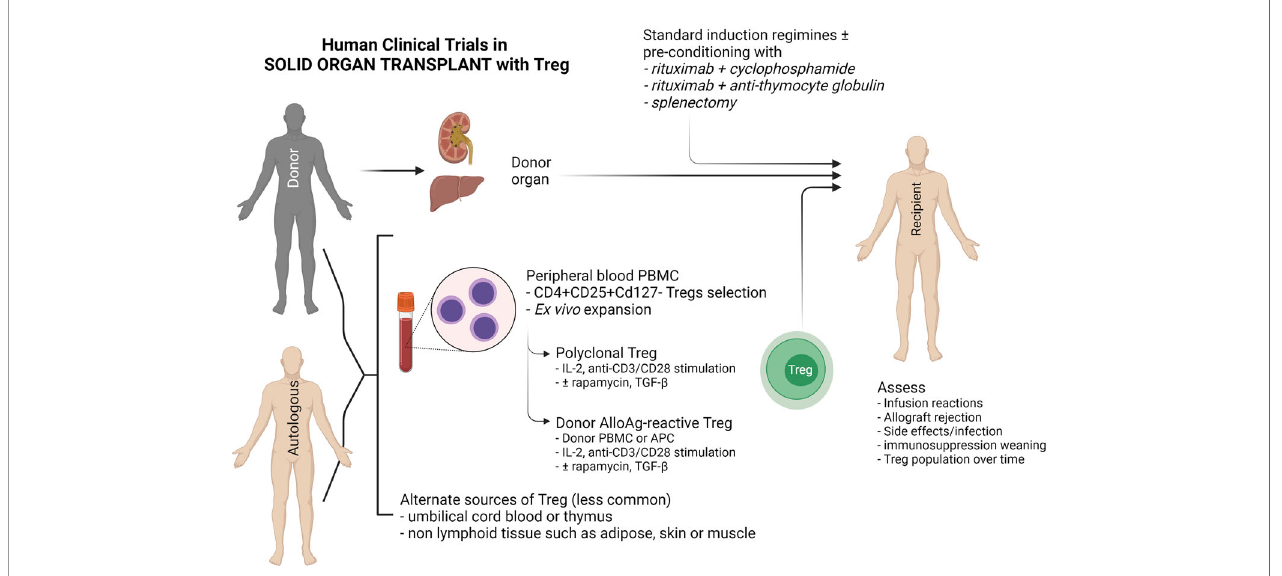
FIGURE 3 | Schematic diagram of current clinical Treg trials in kidney and liver transplantation. This diagram indicates the sources of FOXP3 + Tregs (CD4 + CD25 + CD127 - ), the two main methods of Treg expansion and assessment in clinical